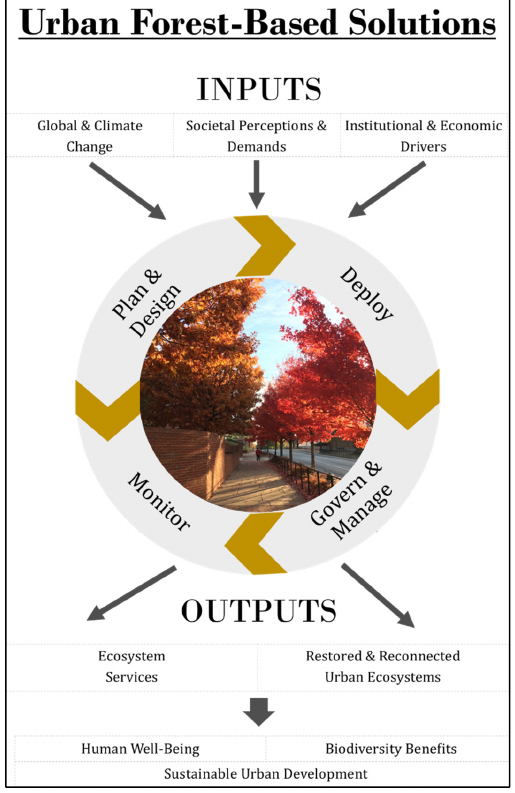
Figure 1. Resilience framework modified from the European Forest Institute Resilience Research Programme [51].